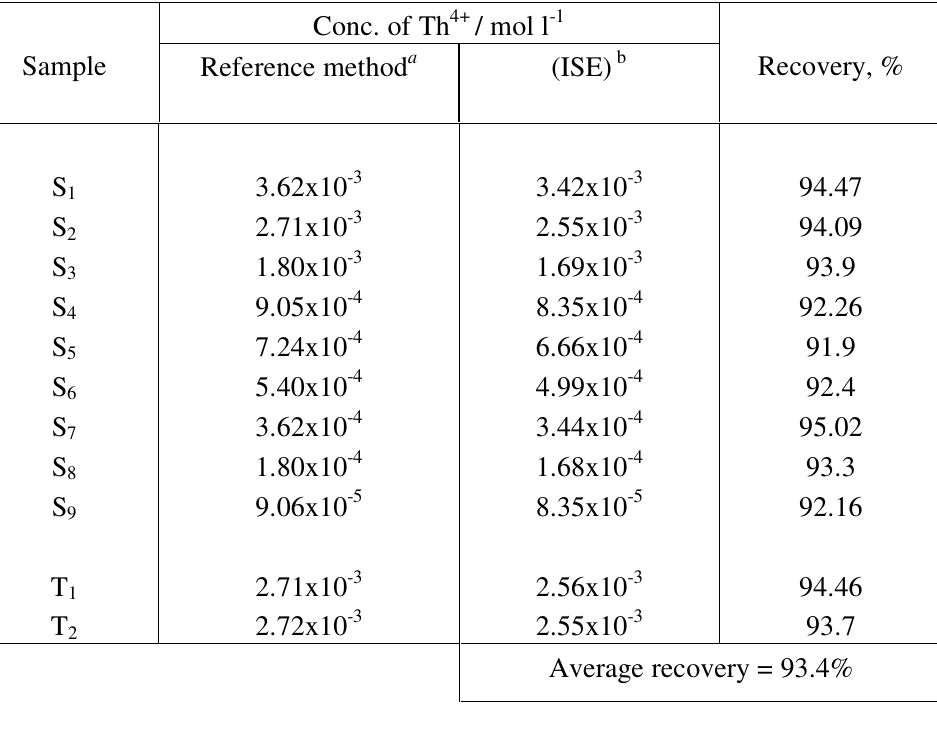
Potentiometric recovery studies on solid-solid reaction ionophore coated graphite rod thorium